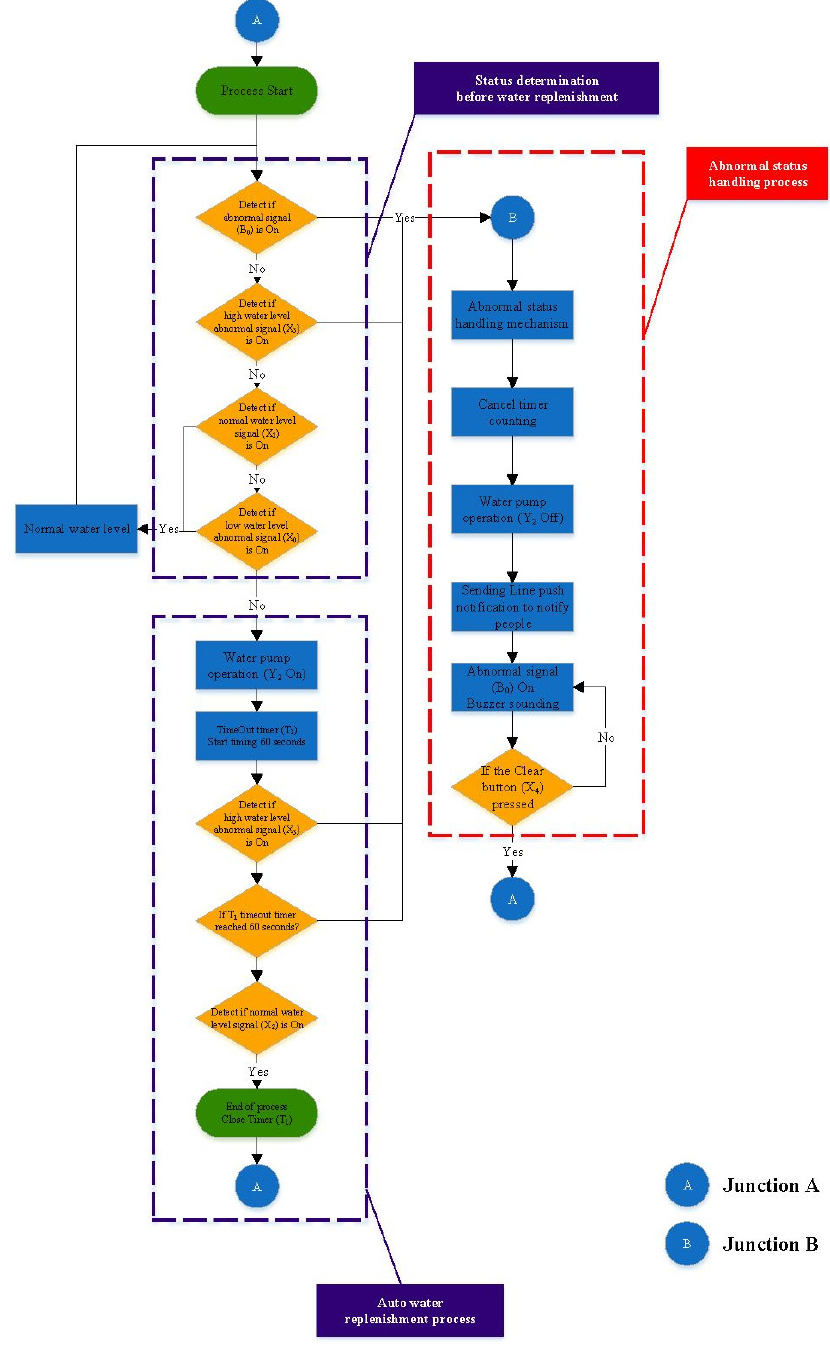
Figure 6. Controller planning flow chart.